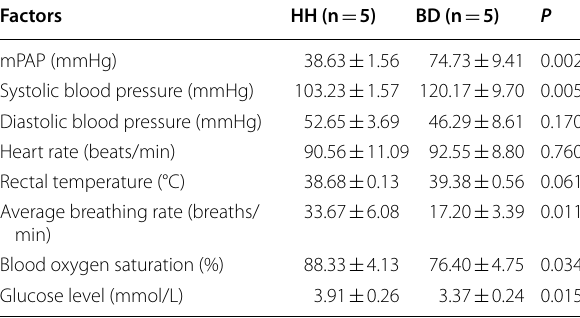
Table 1 Physiological comparison in samples of BD and HH